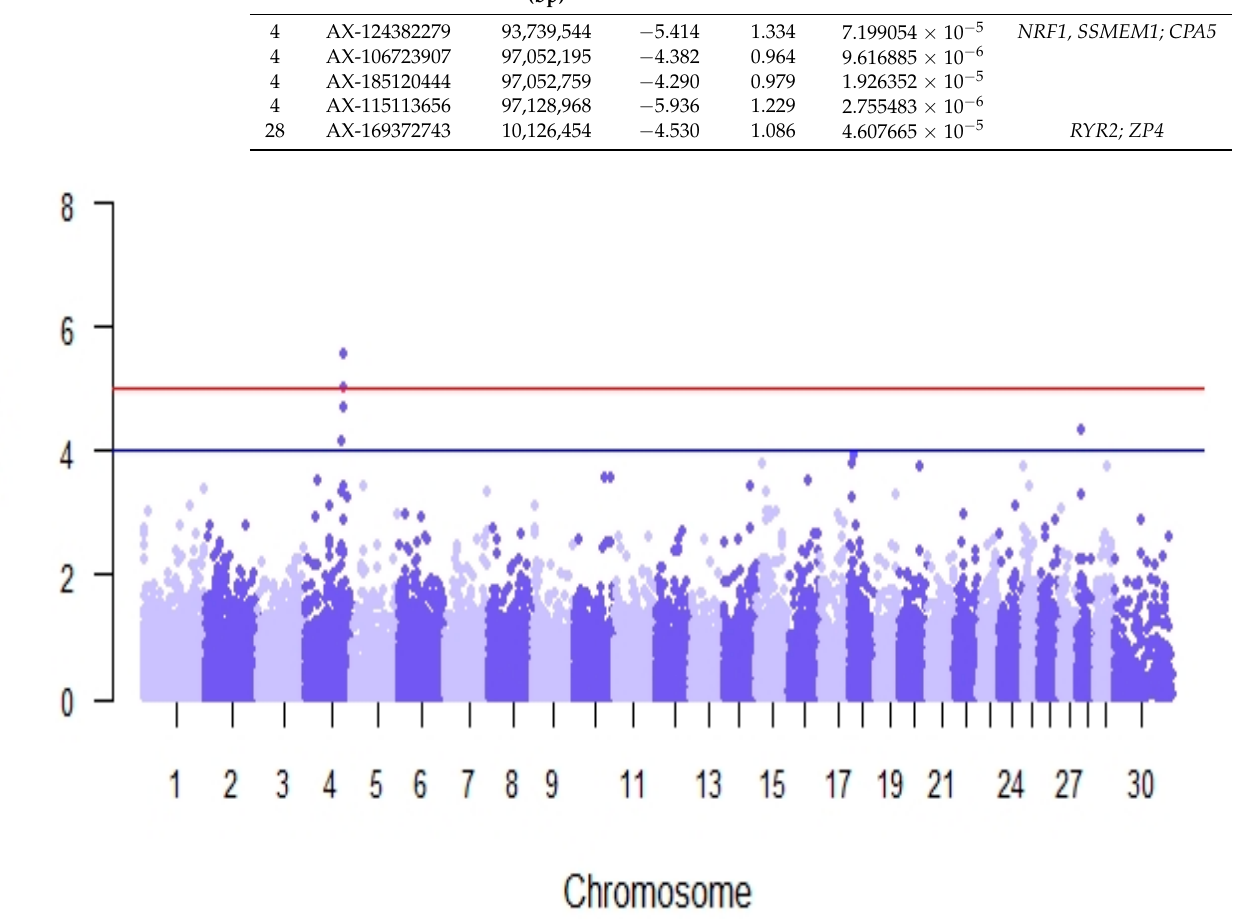
Figure 8. Manhattan plot of genome-wide association analyses for reproductive efficiency in the Retinta breed. The red line shows a genome-wide significance threshold ( − log10( p ) = 5) and the blue line a genome-wide suggestive threshold ( − log10( p ) = 4).